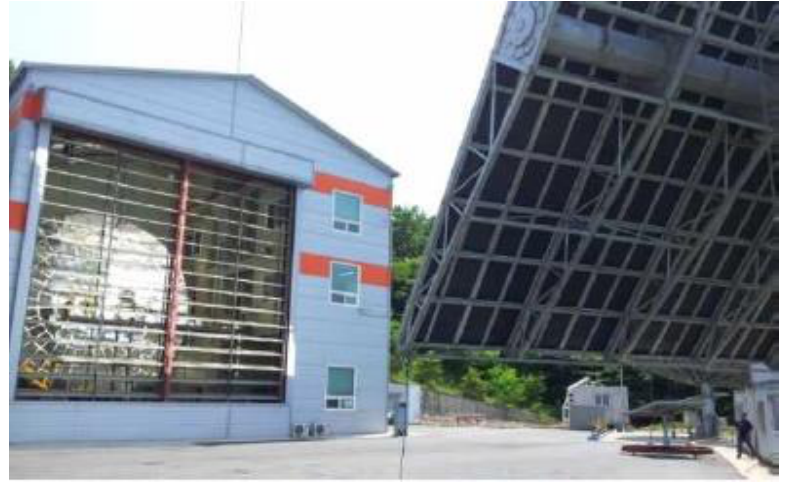
Figure 2. 40 kW th solar furnace at KIER.